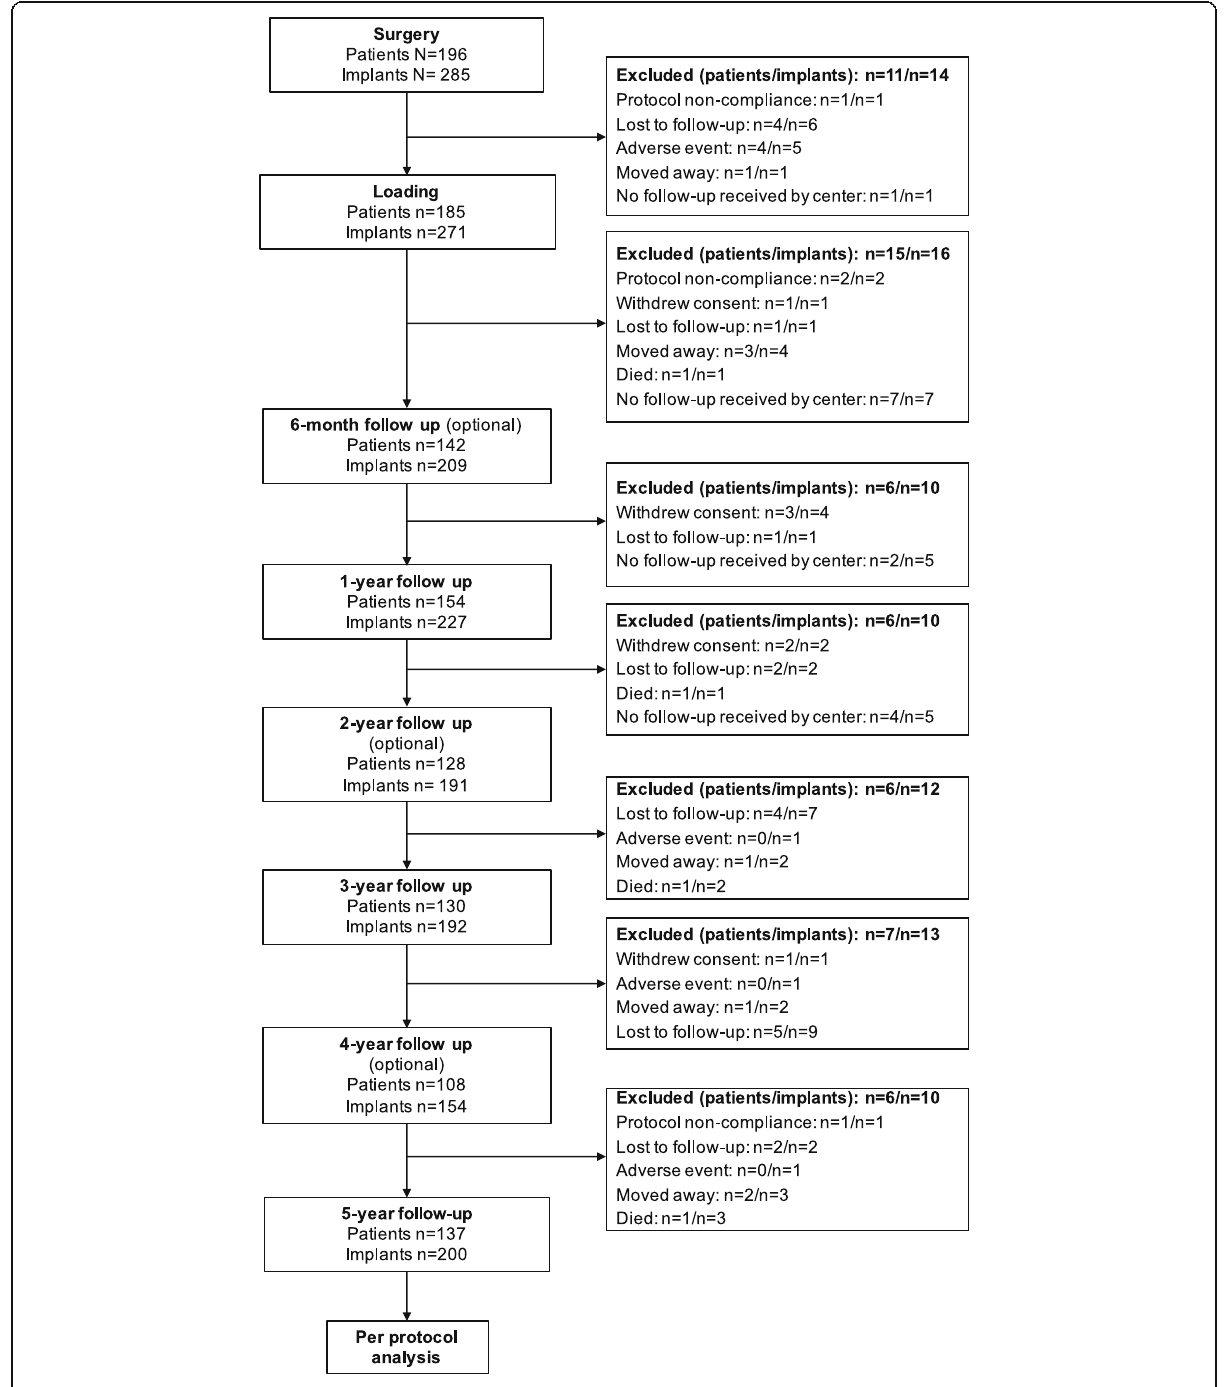
Fig. 1 Study flow diagram: follow up status and reasons for not completing the study; six-month, 2-year and 4-year follow up was